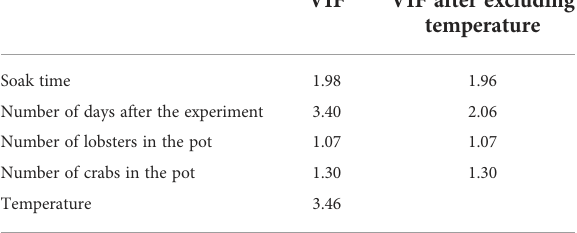
TABLE 4 Multicollinearity test based on Variance In fl ation Factor (VIF).